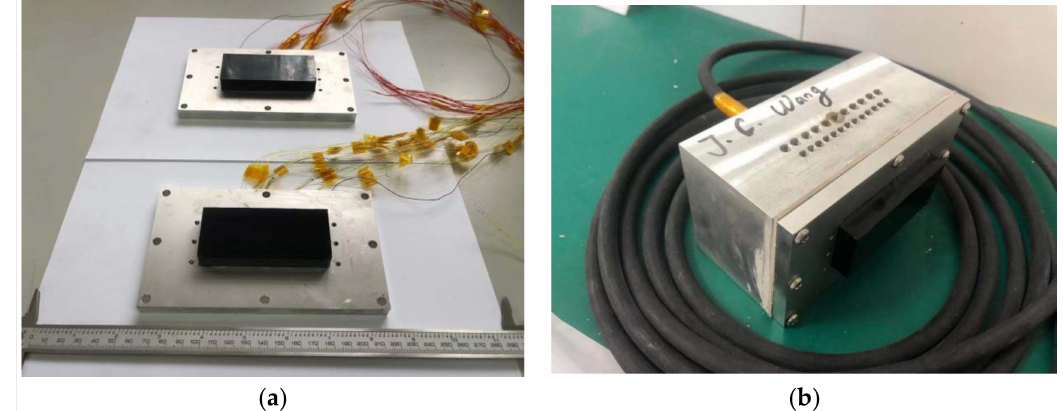
Figure 10. Planar array transducer prototypes. ( a ) Two types of transducer prototypes based on 1–3 piezoelectric composites; ( b ) Prototype of assembled planar array transducer before